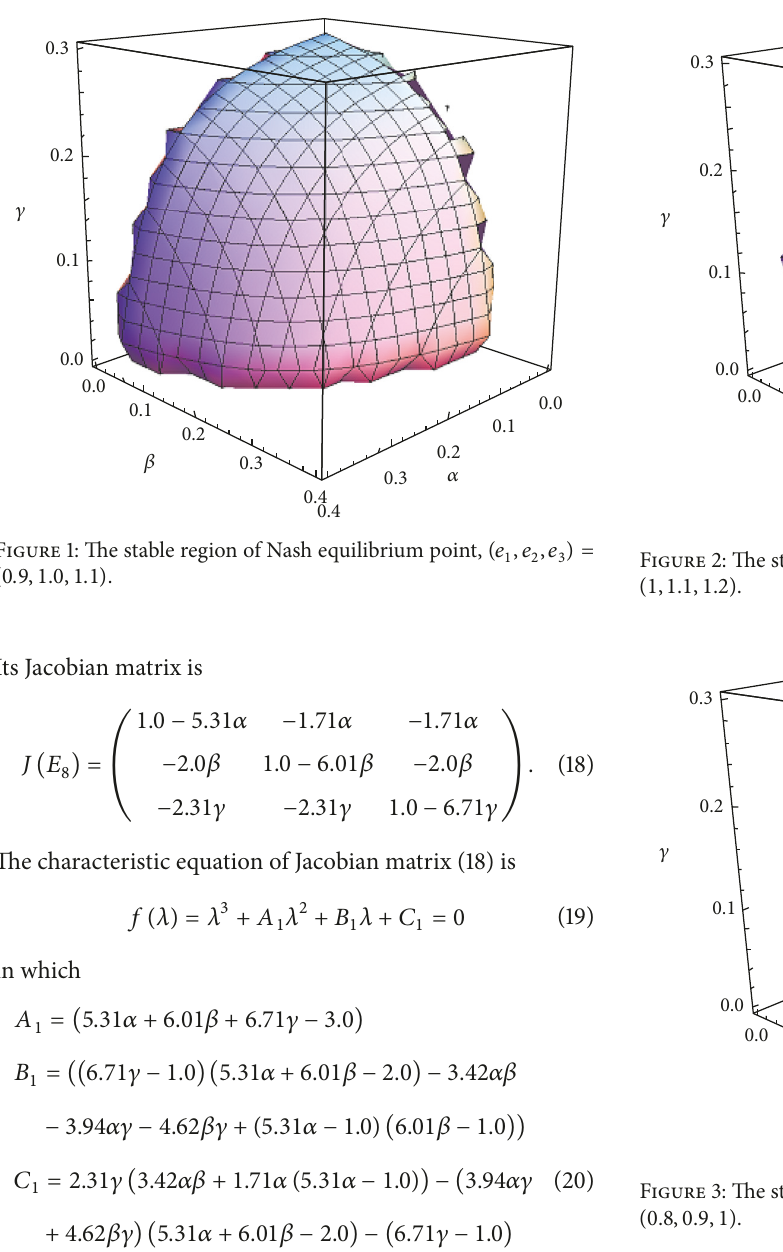
(𝑒 , 𝑒 , 𝑒 ) = (1, 1.1, 1.2) and (0.8, 0.9, 1) , respectively; then 1 2 3 the corresponding stable region is shown in Figures 2 and